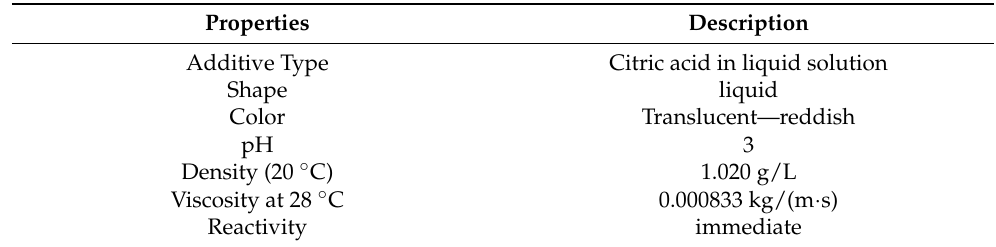
Table 3. General properties of the additive.